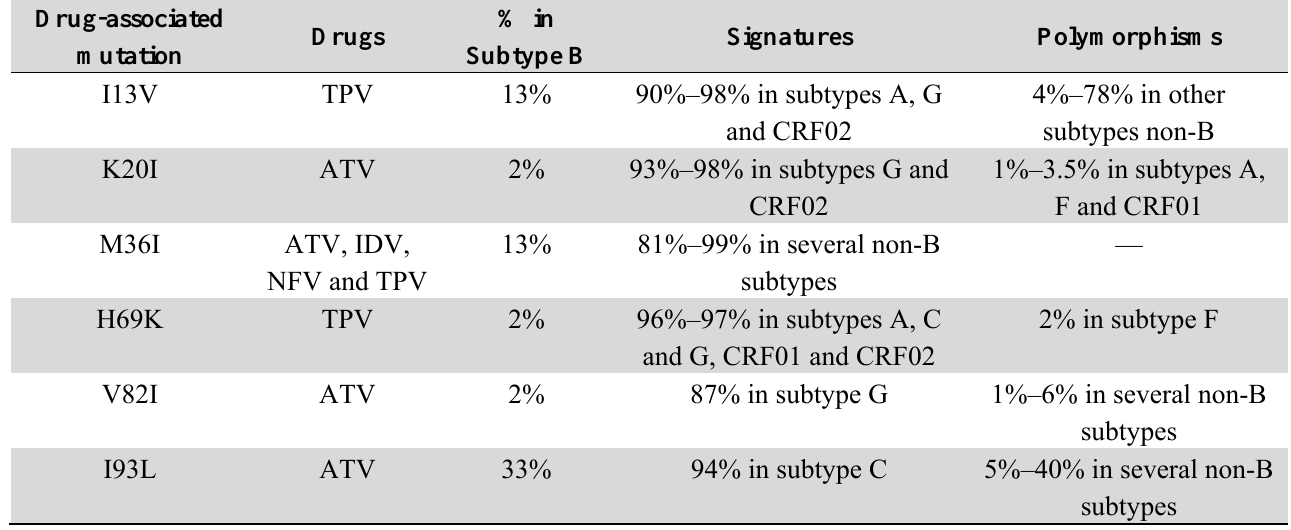
Table 3. Genetic signatures and/or polymorphisms of HIV-1 non-B subtypes associated with resistance to